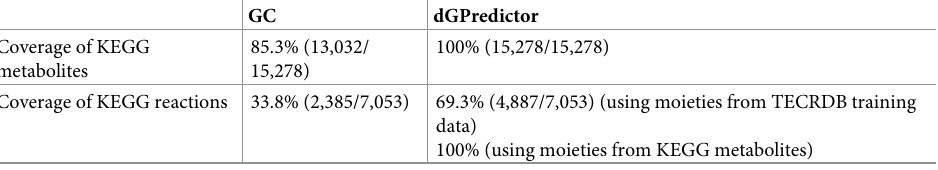
Table 3. Statistics of 15,278 metabolites and 7,053 reactions from KEGG that can be decomposed into groups/ moieties. GC dGPredictor 85.3% (13,032/ 100% (15,278/15,278) Coverage of KEGG metabolites 15,278) Coverage of KEGG reactions 33.8% (2,385/7,053) 69.3% (4,887/7,053) (using moieties from TECRDB training data) 100% (using moieties from KEGG